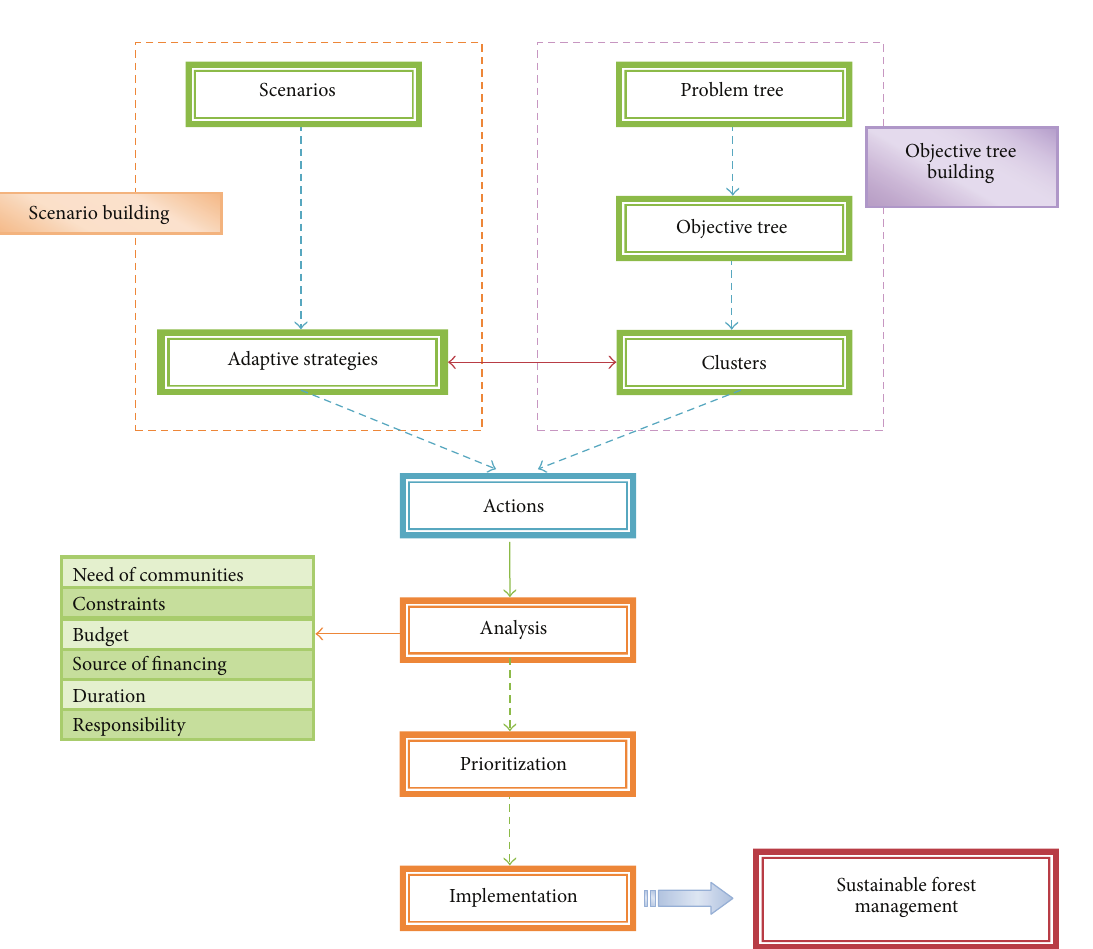
Figure 1: “Back-to-back” methodological approach for sustainable forest